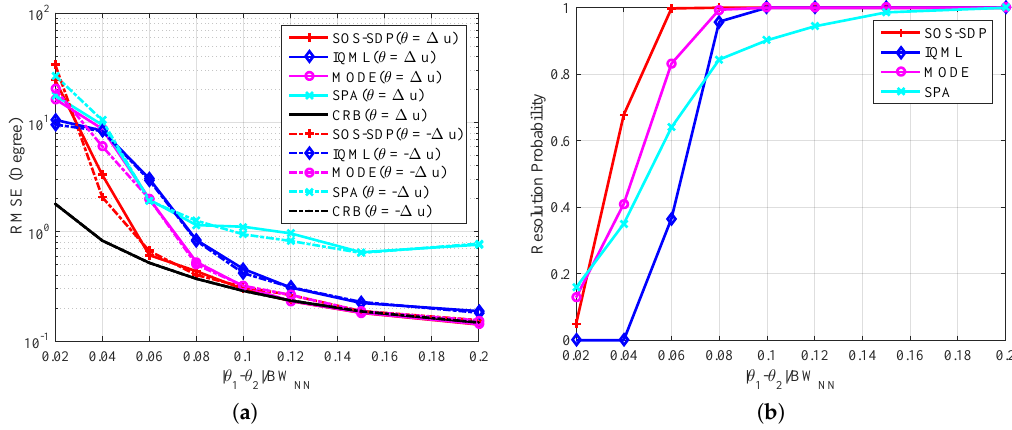
Figure 3. Spatial resolution of different methods with two equal-power coherent sources. Other settings include: ULA with N = 10, number of snapshots N t = 100, and SNR = 10 dB ( a ) RMSE versus distance between sources; and ( b ) resolution probabilities versus distance between